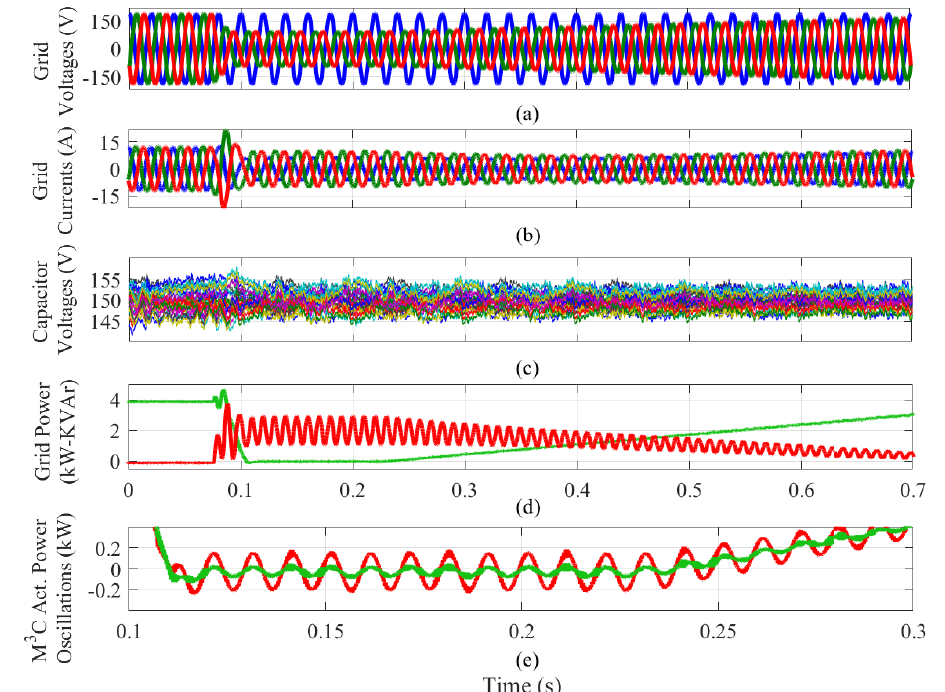
Figure 13. Experimental results obtained for a unbalanced grid fault. ( a ) Output port voltages. ( b ) Output port currents. ( c ) Voltages in the 27 power-cell capacitors. ( d ) Active and reactive powers supplied to the grid. ( e ) Oscillation at the M 3 C terminals. Adapted from